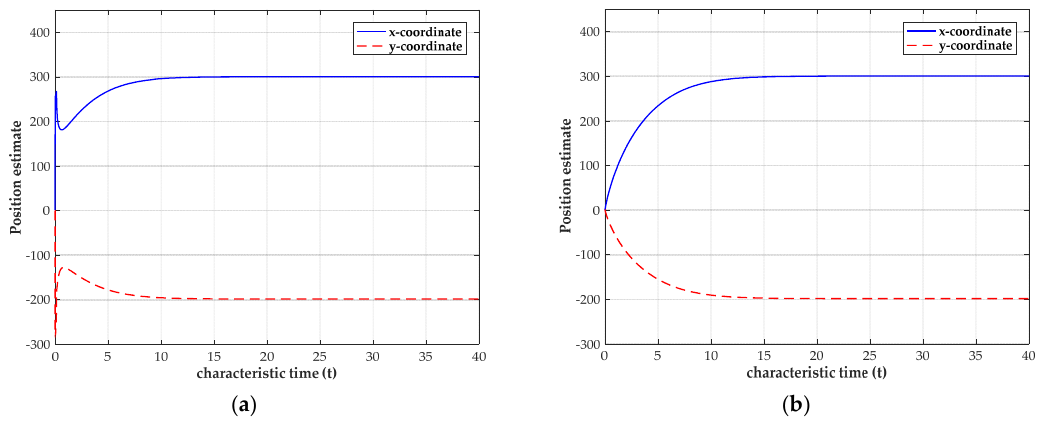
Figure 6. Transient behavior of the estimated source coordinates using noisy TOA measurements with the source position located at ( 300, − 200 ) m. ( a ) Transient behavior when σ 2 = 0.01 m 2 ; ( b ) transient behavior when σ 2 = 1 m 2